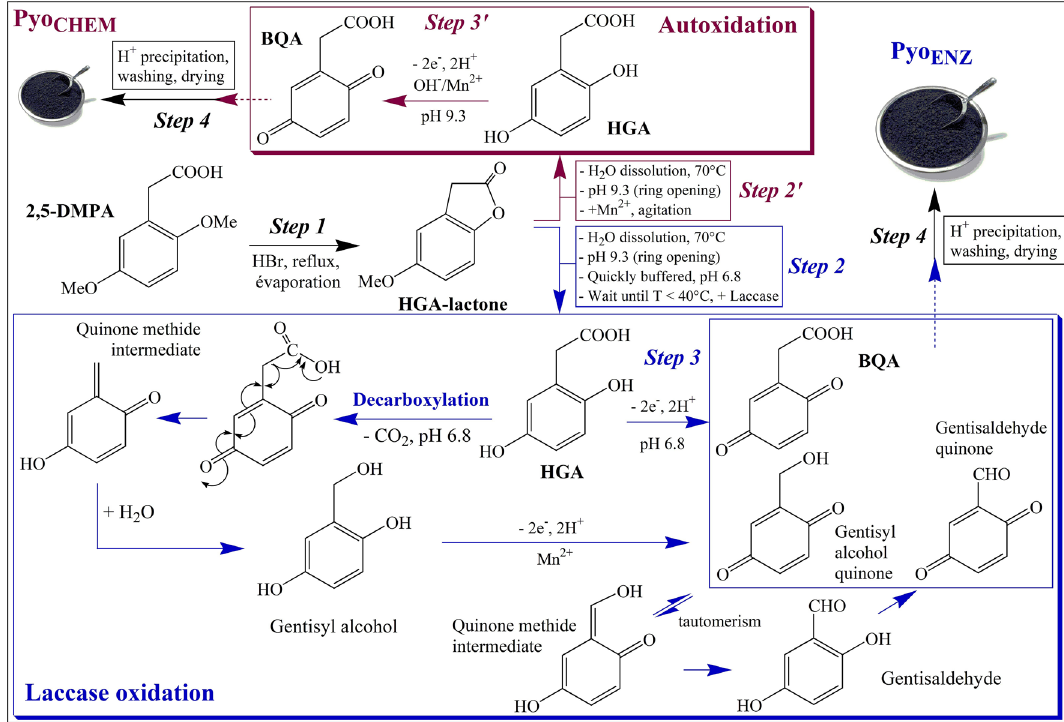
Figure 1. Schematic diagram of the Pyo ENZ process (in blue) that uses a laccase and showing the associated decarboxylation mechanism and the two resulting products identified in the polymer. Comparison to the Pyo CHEM synthesis (abiotic autoxidation, in red). The common precursor 2,5-DMPA could also be synthesized from 2,5-dimethoxyacetophenone by a Willgerodt-Kindler reaction type 25 . Step 4 is the final HCl precipitation followed by washing and drying. Doubling the amount of HBr (step 1) led to incomplete demethylation and the extra formation of 2,5-dihydroxyphenylacetaldehyde (~ 6%) identified from the HPLC-DAD spectrum (λ max 292 nm) and the EI-MS profile (molecular ion [M + 2TMS] at m/z 294, characteristic fragments [M – CHO] at m/z 265, and [M – CH 2 CHO] at m/z 251), similarly to the NIST data bank and previous data 34 . In step 2, the addition of sulfite (Na 2 SO 3 ) 25 was unnecessary because the solution was immediately buffered to 6.8 and the polymerization by the laccase followed (step 3). The alkaline opening of the lactone was essential, indeed the rMt laccase was unable to open the lactone nor demethylate 2,5-DMPA at pH 6.8, even after several days of agitation. BQA, 1,4-benzoquinone acetic acid; gentisaldehyde, 2,5-dihydroxybenzaldehyde; gentisyl alcohol, 2,5-dihydroxybenzyl alcohol; 2,5-DMPA, 2,5-dimethoxyphenylacetic acid; 2,5-DMAPO,